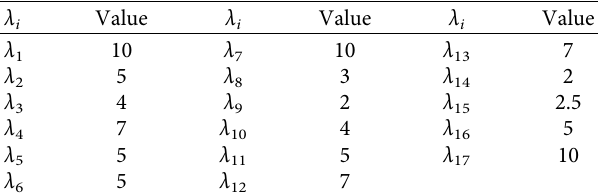
Table 3: Average implementation rate of each delay